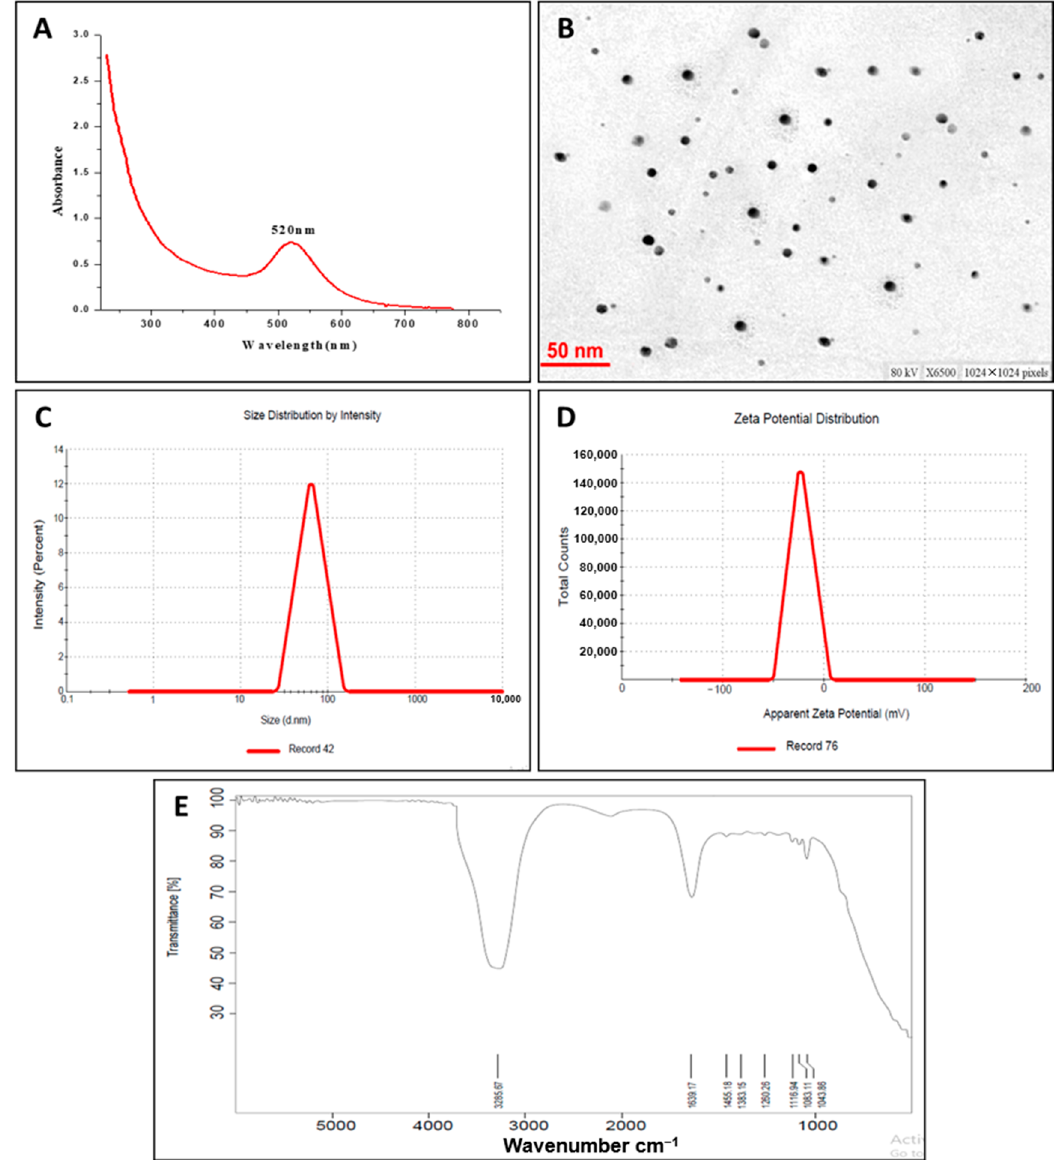
Figure 1. Characterization of gold nanoparticles (GNPs): ( A ) UV–VIS spectroscopy, ( B ) transmission electron microscopy, ( C ) dynamic light scattering, ( D ) zeta potential, and ( E ) Fourier transform infrared (FTIR) spectrum.